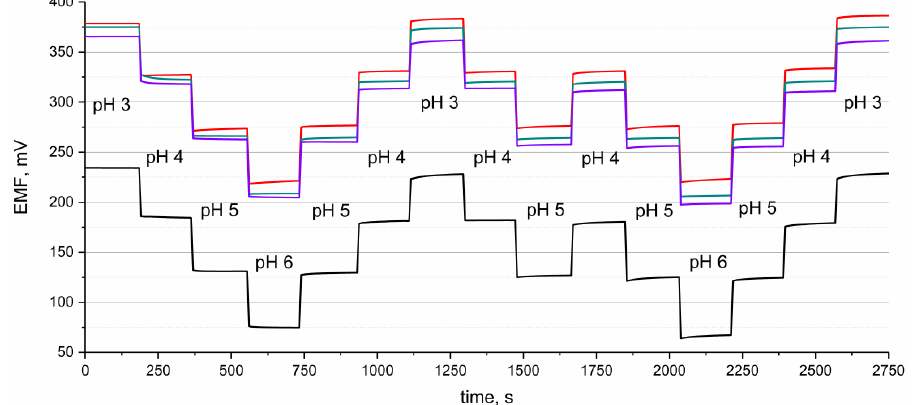
Figure 3. Potential reversibility of GC/hIrO 2 /H + -ISM (red line), GC/hIrO 2 +NTs/H + -ISM (green line), GC/hIrO 2 +NTs+POT/H + -ISM (purple line) and GC/H + -ISM (black line) electrode recorded in the buffer solution of pH 3, 4, 5 and 6, alternately.